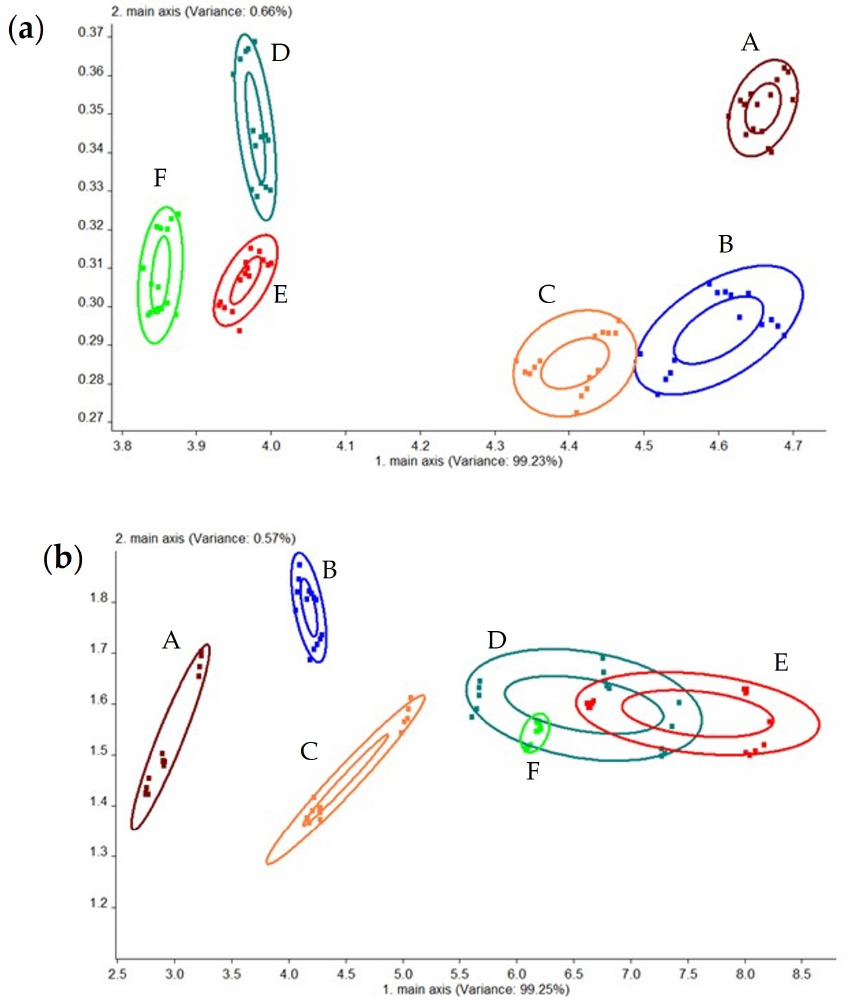
Figure 6. Principal component analysis (PCA) based on electronic nose data produced by different stirred yoghurt samples of the homogenized goat milk (A), goat milk, high-intensity thermosoni- cated for 5 min (B), 10 min (C), 15 min (D), homogenized cow milk (E) and cow milk, high-intensity thermosonicated for 15 min (F) on the first day ( a ) and on the 18 th day ( b